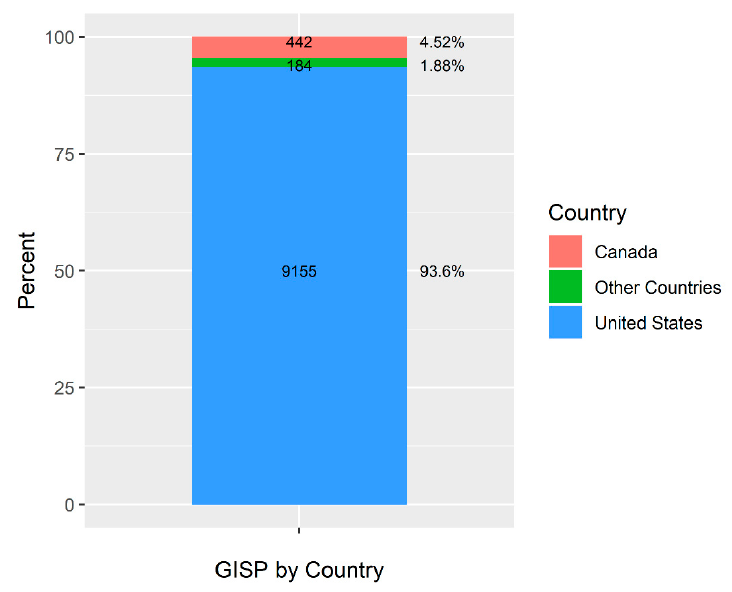
Figure 2. The number of GISPs in the U.S., Canada, and other countries.